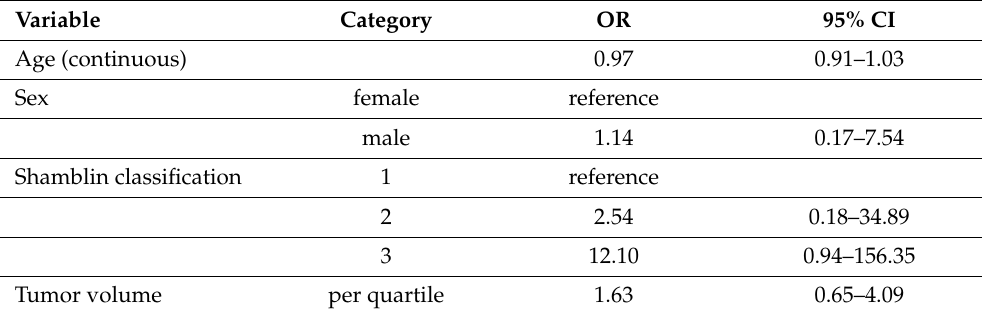
Table 4. Results of logistic regression analysis with postoperative complications as dependent variable. Hosmer–Lemeshow test: p =